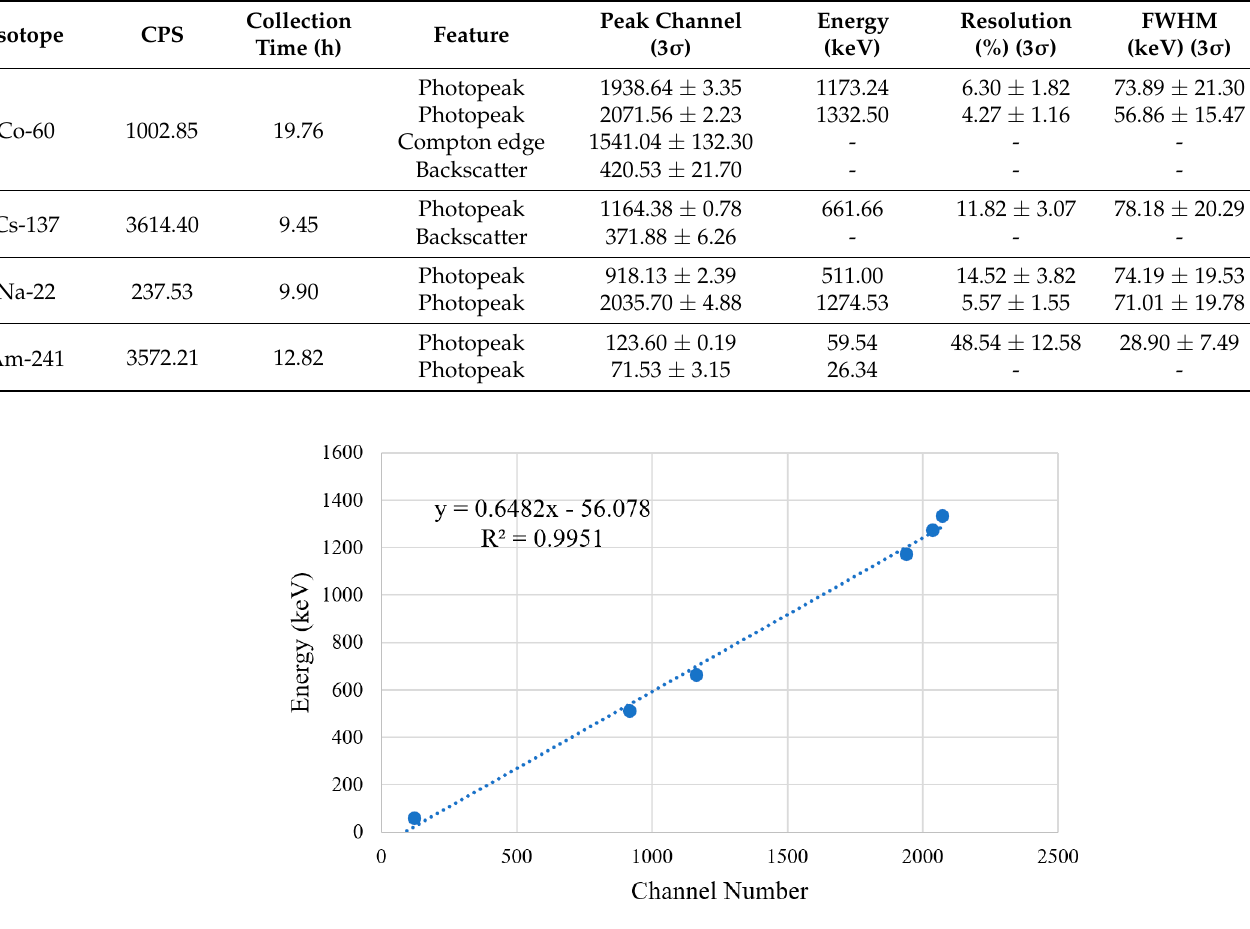
Figure 17. Graph of the calibration fit for the detector with three-sigma error bars based upon the collected peak channel data in Table 2. A linear line of best fit (dotted blue line) has been fitted to the data in order to relate each channel to a detection energy. The fit has a gradient and intercept standard error of 0.65 ± 0.02 and − 56.08 ± 35.39, respectively (a 95% confidence interval).